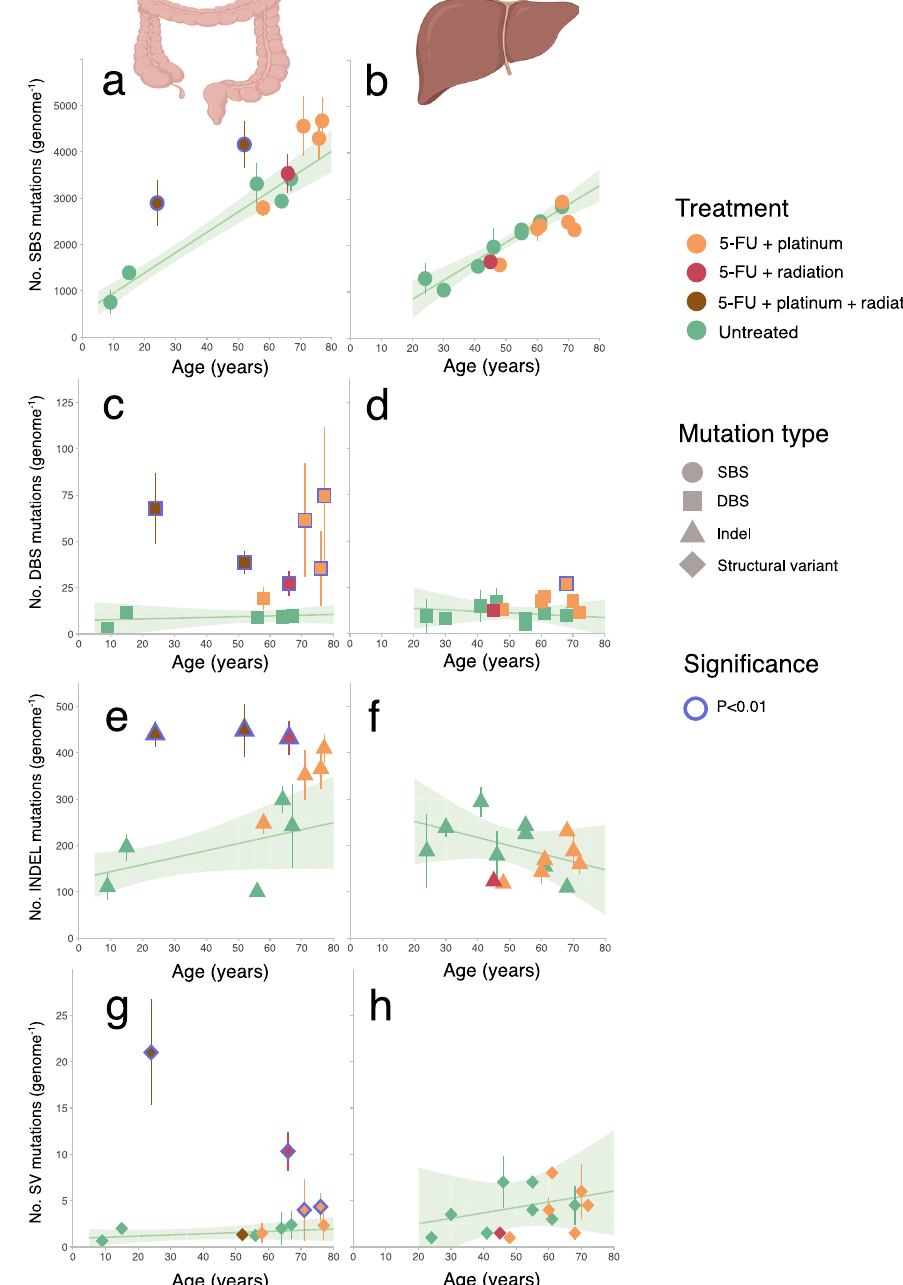
Fig. 2 | Mutational impact on mutation burden. a , b Singe base substitution (SBS), c , d doublebase substitution (DBS), e , f indeland g , h structural variant(SV) mutation burden ( y axis) as a function of age ( x axis) for respectively healthy colorectal and liver ASCs. Each data point represents the mean mutation burden per donor and the error bars represent the standard deviation of the mutation burden. The color of each point depicts the treatment history. The number of sequenced ASC per donor ( n ) varies from 1 up to 6 samples and is listed in Fig. 1a. The cohort size for treated and untreated colorectal ASCs are respectively 6 and 7